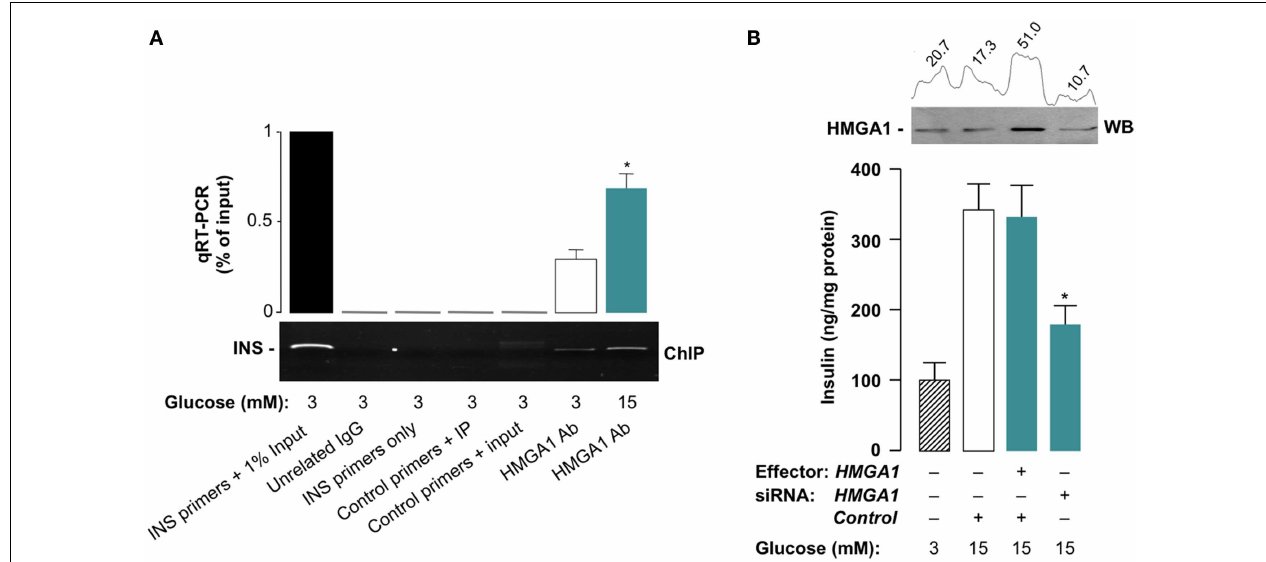
p < 0.05 versus control (white bar). (B) Insulin secretion from HMGA1 siRNA-treated INS-1 cells. Results are the mean ± SEM for three independent experiments conducted in triplicate. p < 0.05 versus control (white bar). A representativeWB of HMGA1 is shown in the autoradiogram, together with densitometric slot blot analysis in each